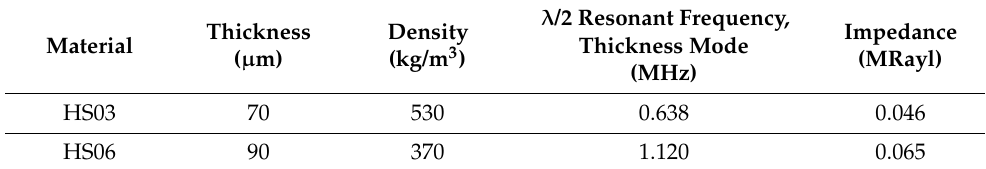
Table 1. Properties of the FE films employed [10].